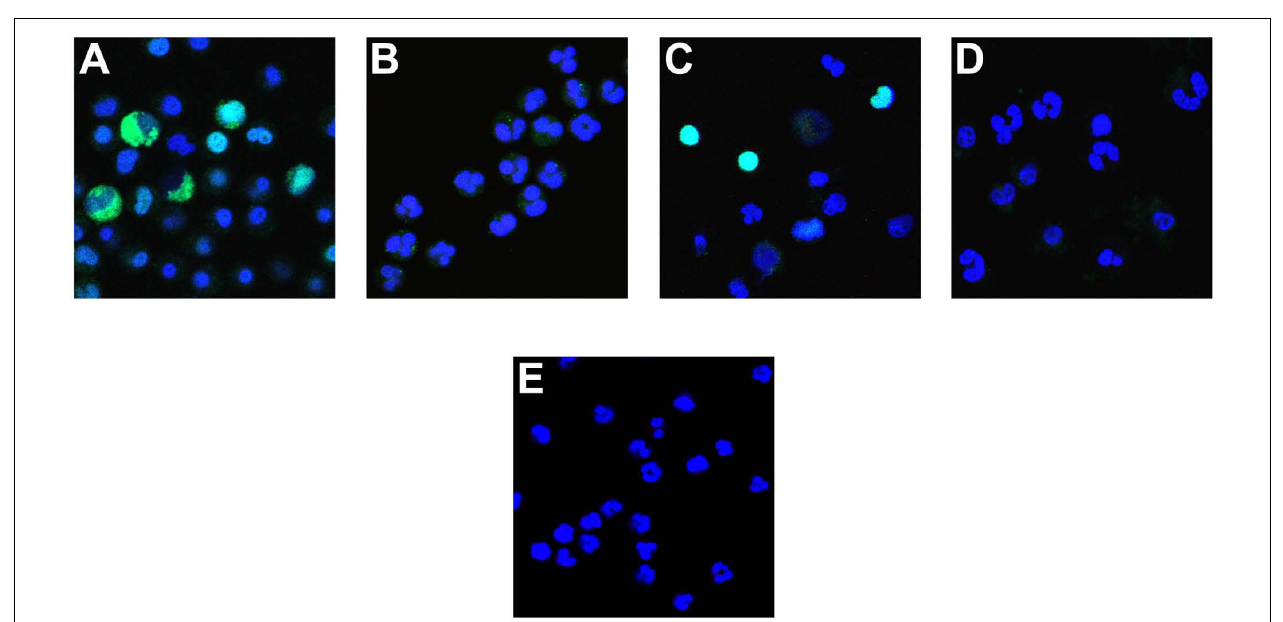
FIGURE 4 | Effect of PKC inhibitors on NETosis. Neutrophils were incubated with A23187 ionophore in the presence of 5 μ M chelerythrine (A) , or 20 μ M chelerythrine (B) . Antibody binding to deiminated histone H3 (green) and the DNA contained in cells or released as NETs (blue) was observed in 5 μ M chelerythrine, whereas 20 μ M inhibitor precluded deimination and most other morphologic features of NETosis. Cells incubated